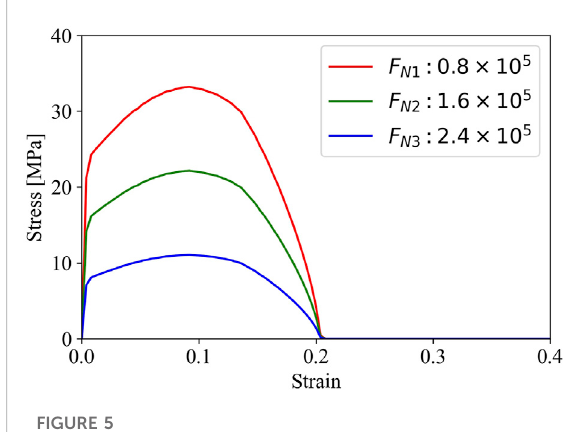
FIGURE 4 The role of the microstructural arrangement of fi ber in modifying the stress-strain behavior of a fi brous microstructure that consists of fi brous minerals characterized by Young ’ s modulus, diameter, and strain at fracture equal to 25 GPa, 1.12 nm, and .004, respectively. The stress-strain response transitions from brittle (red curve) to ductile (blue curve) as the arrangement of fi bers within the microstructure evolves from ordered and aligned to disordered and entangled. The ductile response (blue curve) exhibits a saw-tooth pattern (magni fi ed insert), which results from thecontribution to thebulk response of the load – displacement characteristic of a single fi ber described in Figure 2B.